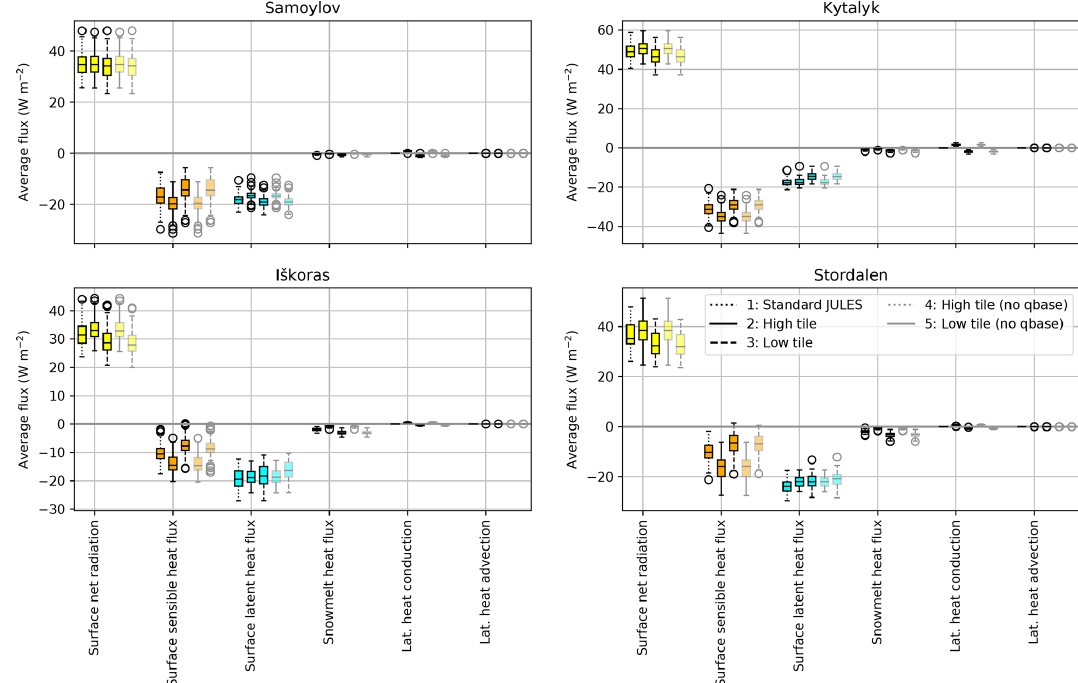
Figure B4. Average yearly simulated energy fluxes (1950–2016) for all sites with the qbase on configuration. Fluxes for the qbase off configuration are shown in grey for